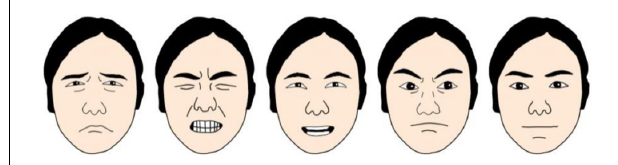
FIGURE 1 | A sample set of five faces used in Experiment 1. From left to right: sad, painful, happy, angry, and